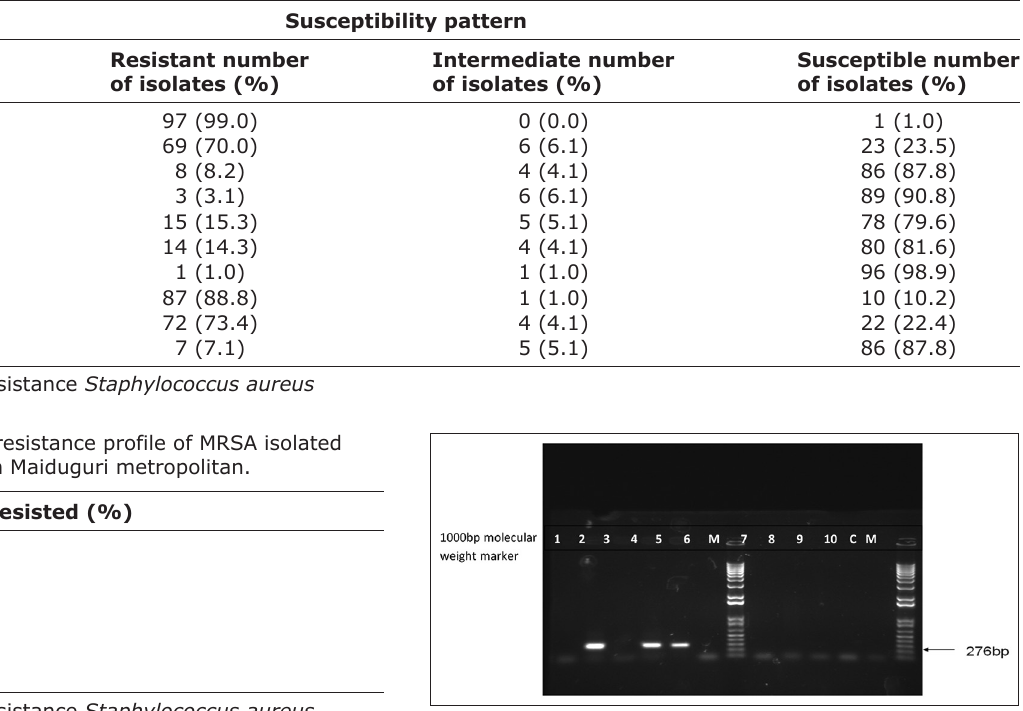
Figure-2: Agarose gel electrophoresis of polymerase chain reaction of methicillin-resistance Staphylococcus aureus isolate. Lanes 2, 4,and 5 are positive for nuc gene as indicated by 276 bp.Lane 1, 3, 6, 7, 8, 9, and 10 are negative samples. Lane M is the molecular weightmarker. Lane C is the negative control.